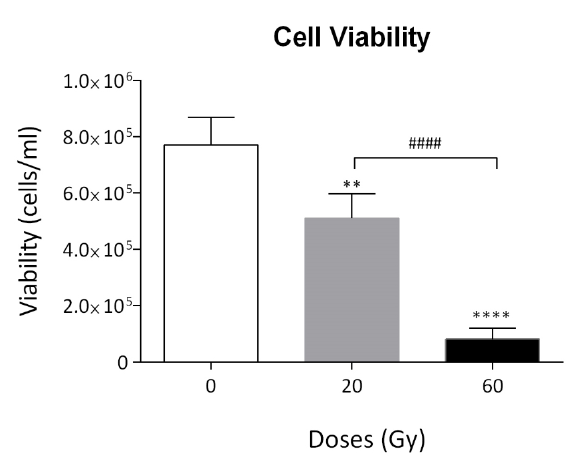
Figure 6. Cell viability after total dose of SBRT. Cell viability was measured by integrity of the plasma membrane and expressed as viable A549 cells by ml of culture. Results are expressed as mean ± SD. One- way ANOVA and post-hoc Tukey’s test, **** p < 0.0001 versus untreated control cells and #### p < 0.0001 versus cells treated with